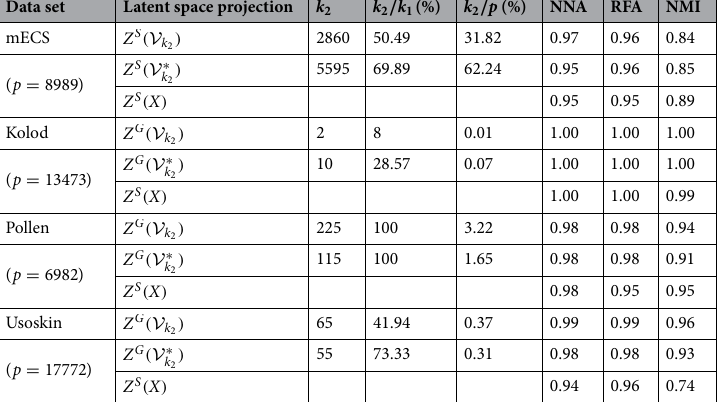
Table 2. k 2 , k 2 / k 1 , k 2 / p , NNA, RFA and NMI based on Z l ( V k 2 ) , Z l ( V ∗ k